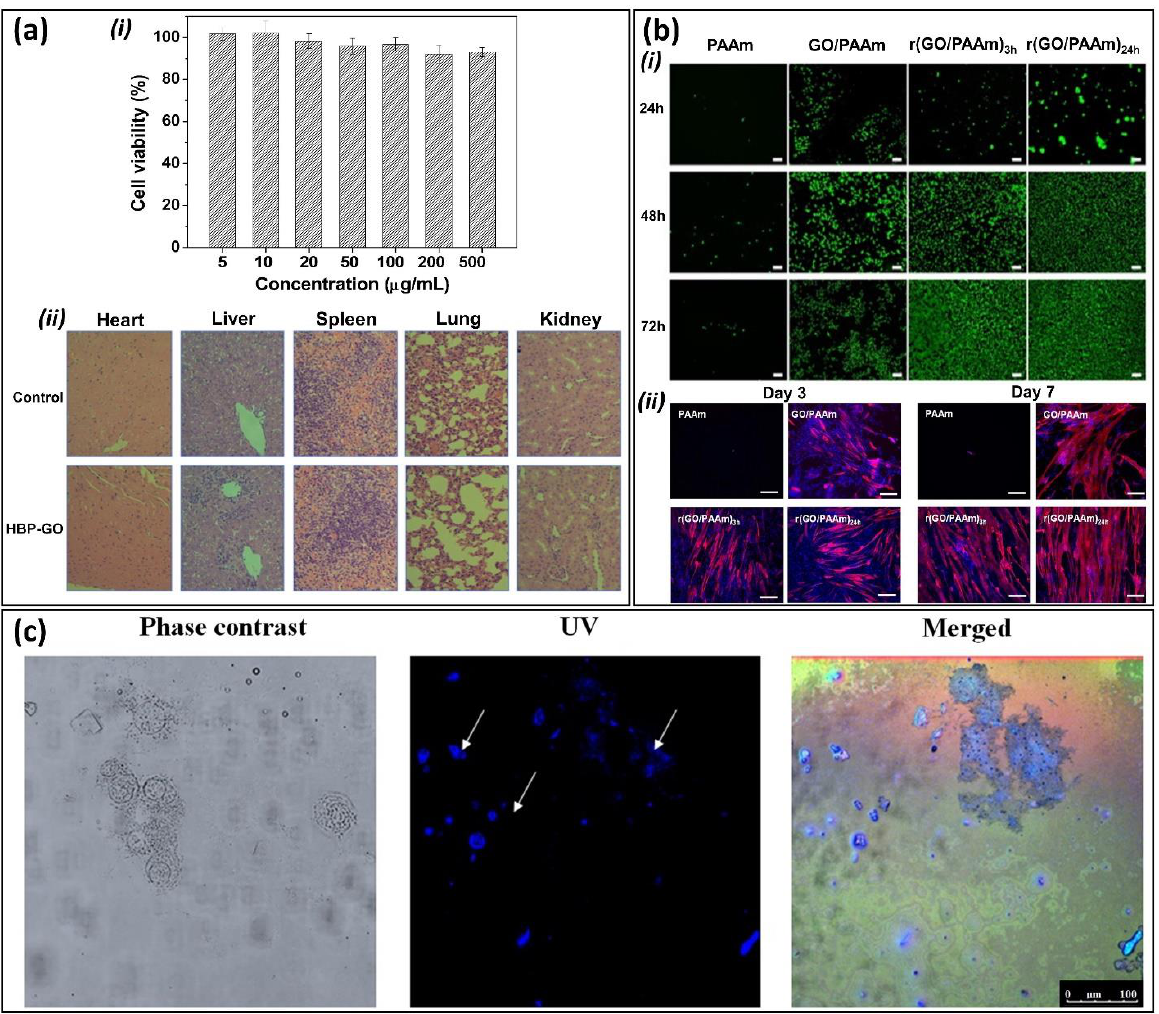
Figure 4. Biocompatibility and bioimaging properties of graphene-based nanocomposites. ( a ) Cytocompatibility of hyperbranched polyglycerol-modified graphene (HPG-GO) on (i) mouse fibroblast NIH-3T3 cell line in vitro at different concentrations of HPG-GO or (ii) in vivo histology of different mouse organs at 500 mg/kg HPG-GO. Adapted with permission from [91] . ( b ) Biocompatibility of different composites of polyacrylamide (PAAm), graphene/PAAm (GO/PAAm) and conductive GO/PAAm hydrogel synthesized after 3 h (r(GO/PAAm)3h) or 24 h (r(GO/PAAm)24h) reduction time on in vitro growth (i) and differentiation (ii) of myoblast C2C12 cells. Adapted with permission from [96] . ( c ) Bioimaging properties of GGels confirmed by incorporation of AgNPs capped GO hydrogels in macrophage using confocal fluorescence microscopy. Adapted with permission from [102] .